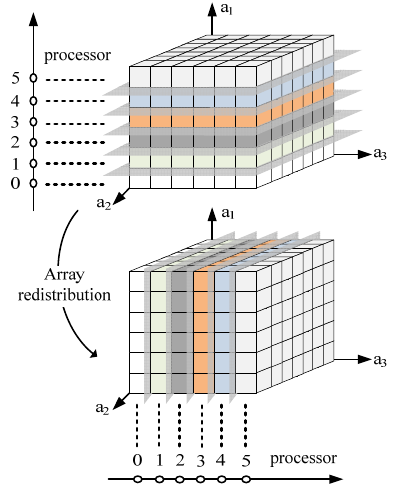
Figure 8. Data-reorganization